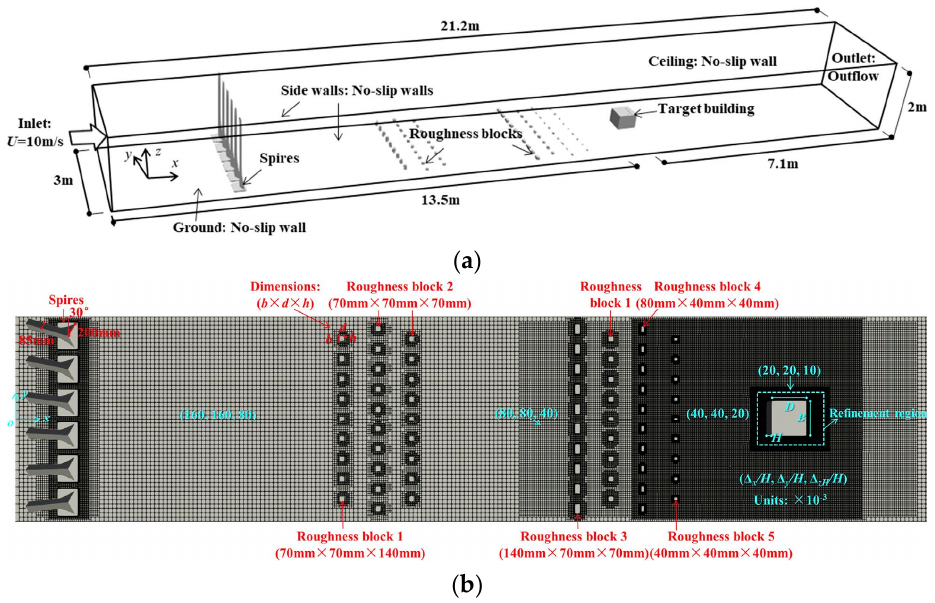
Figure 8. Schematic diagram of computation domain for LES: ( a ) Computational domain and boundary conditions; ( b ) Computational mesh [59].